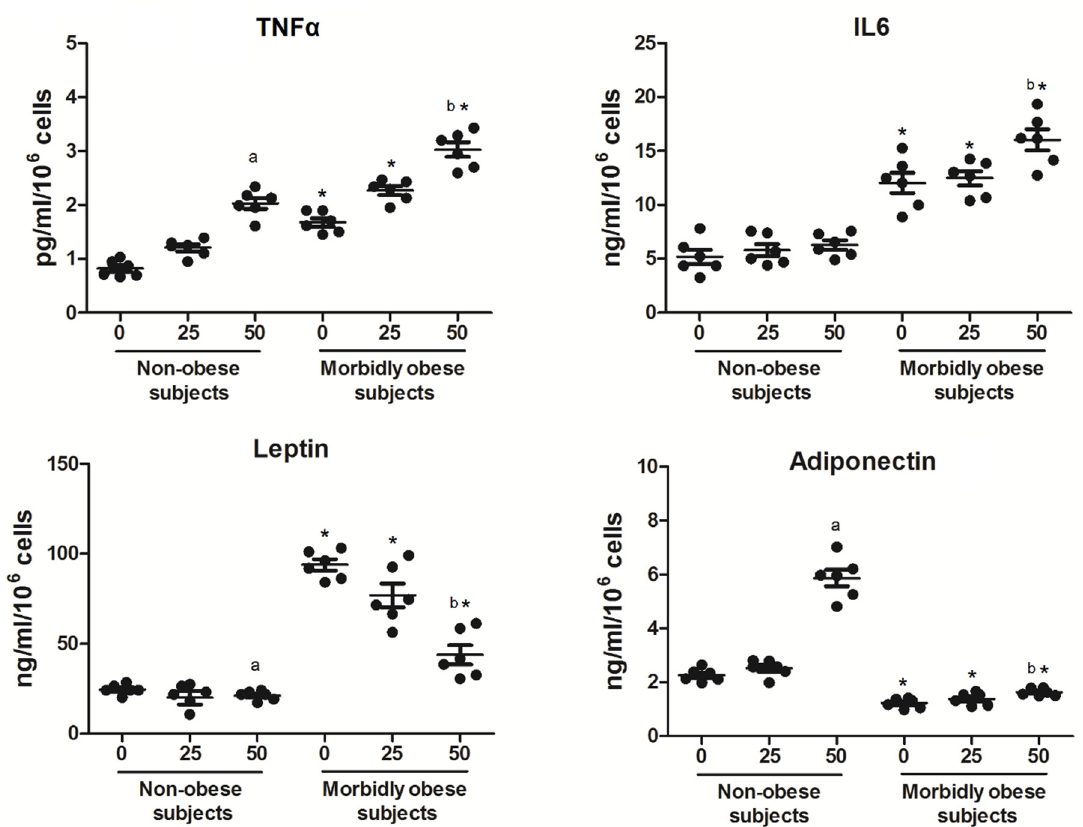
Figure 4. Levels of adipocitokines in the culture medium of in vitro di ff erentiated adipocytes obtained from HMSC from non-obese ( n = 6) and morbidly obese subjects ( n = 6) incubated with 0, 25, and 50 µ g / mL of oxLDL for 24h. a p < 0.05: significant di ff erences with regard to 0 µ g / mL oxLDL within non-obese subjects. b p < 0.05: significant di ff erences with regard to 0 µ g / mL oxLDL within morbidly obese subjects. * p < 0.05: significant di ff erences for each dose between non-obese and morbidly obese subjects.